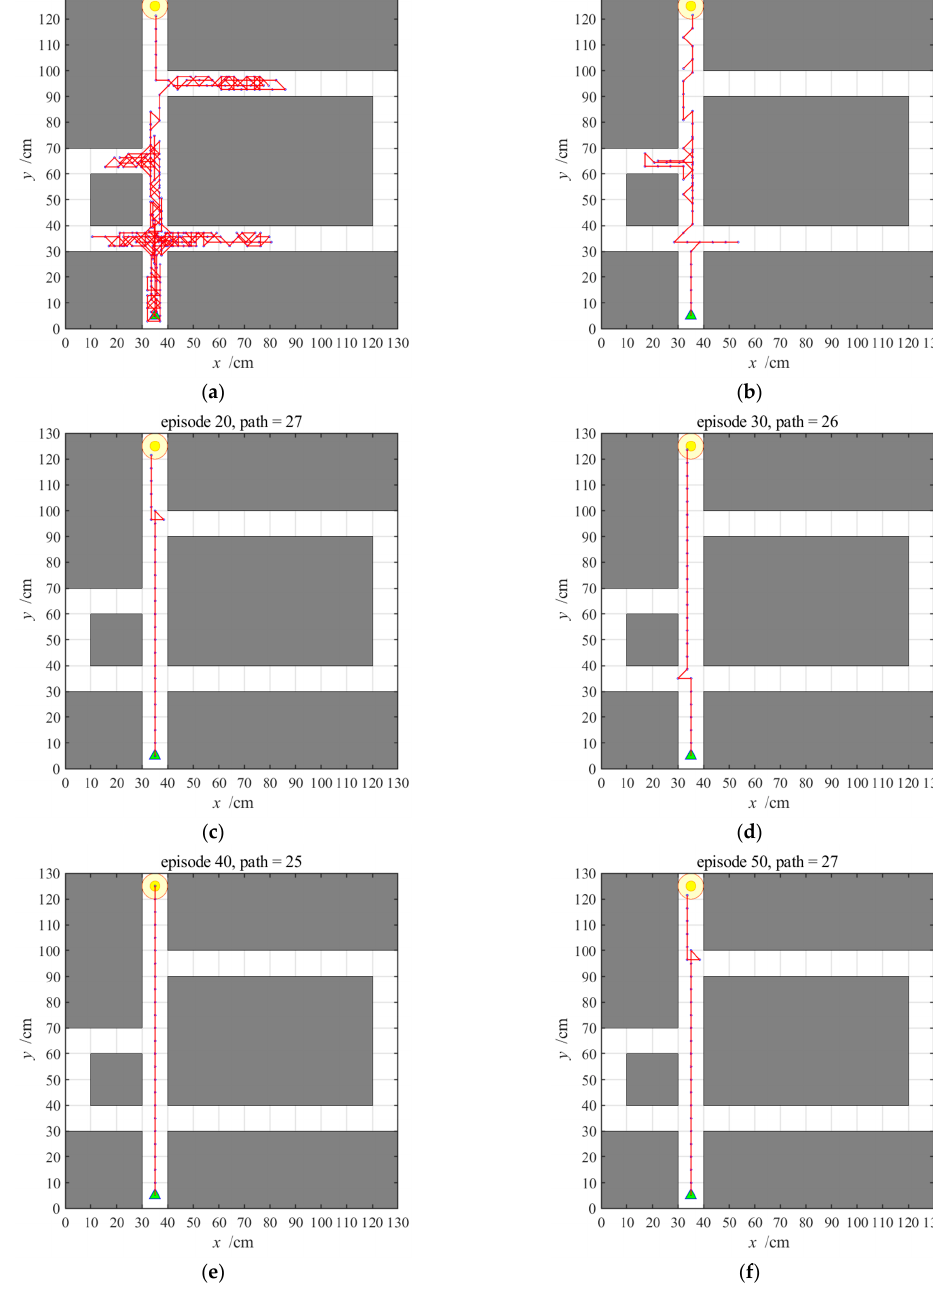
Figure 10. Navigation path with the striatal model alone; ( a – f ) show navigation paths in the 1st, 10th, 20th, 30th, 40th, and 50th episodes, respectively. The episode number and the path length measured by the steps in each experiment are shown at the top of the panels.